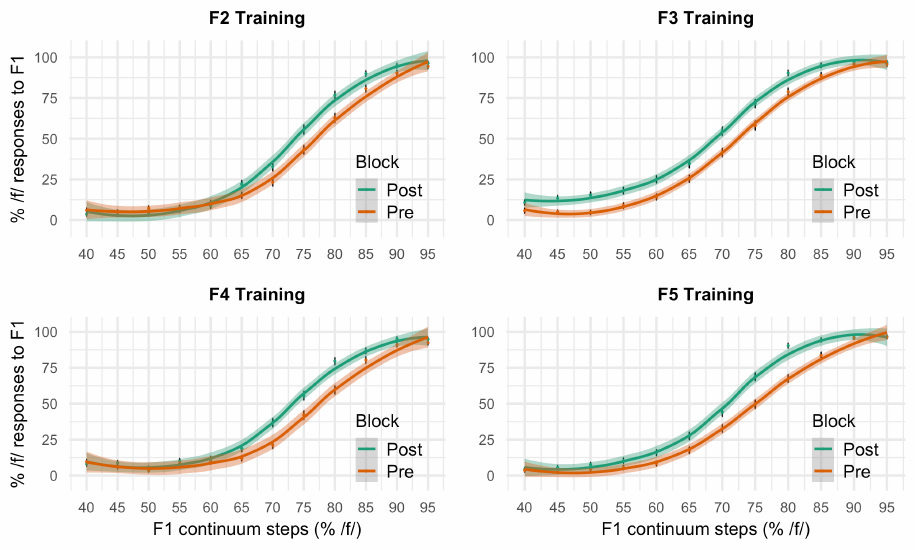
Figure 2: Pre-test and post-test classi(cid:976)ication for F1 continuum (F2-F5 training)